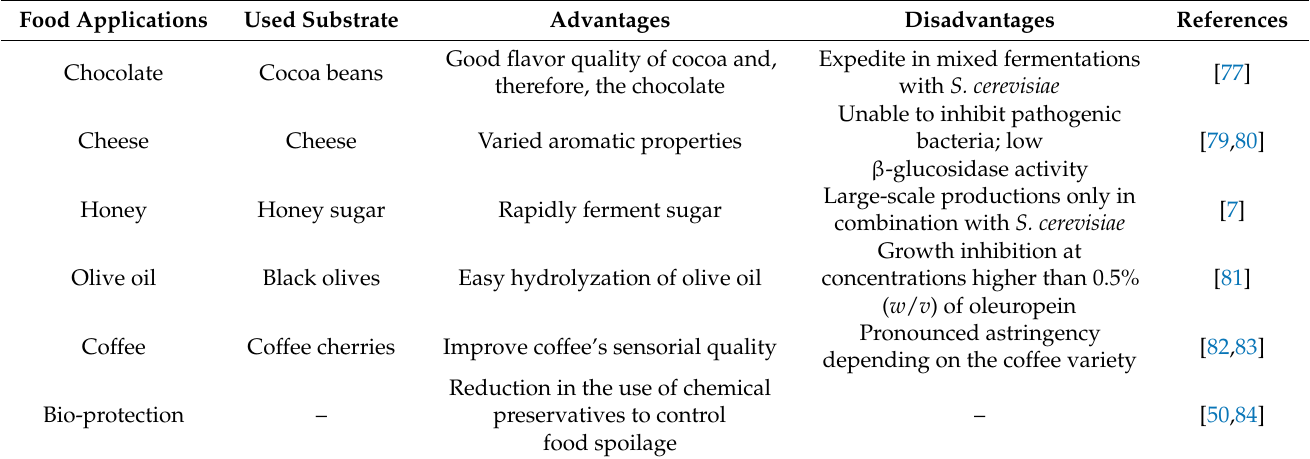
Table 3. T. delbrueckii industrial food